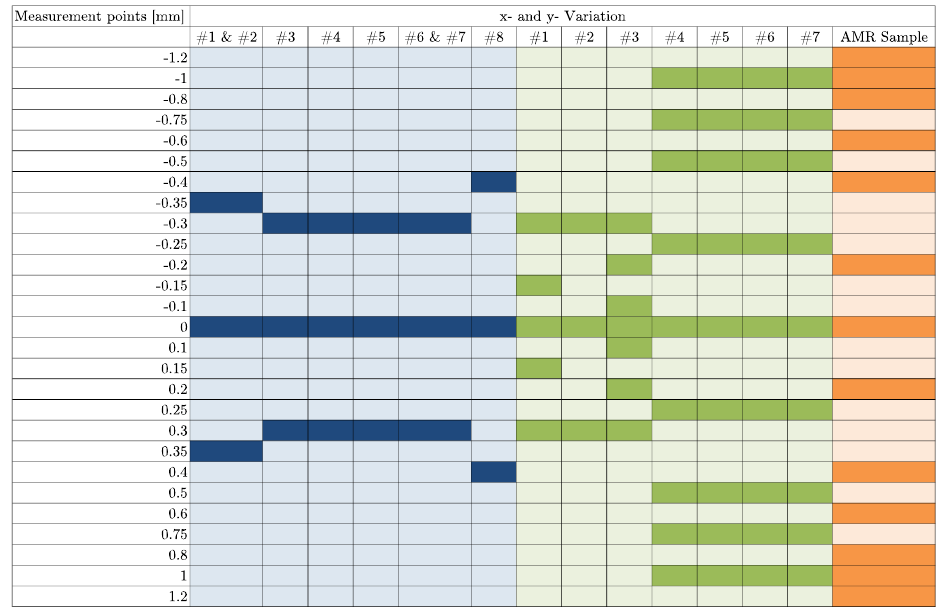
Figure A2. Test case plan for the x and y variation to evaluate all available sensors; blue, resolvers; green, inductive sensors; orange, AMR sensor.